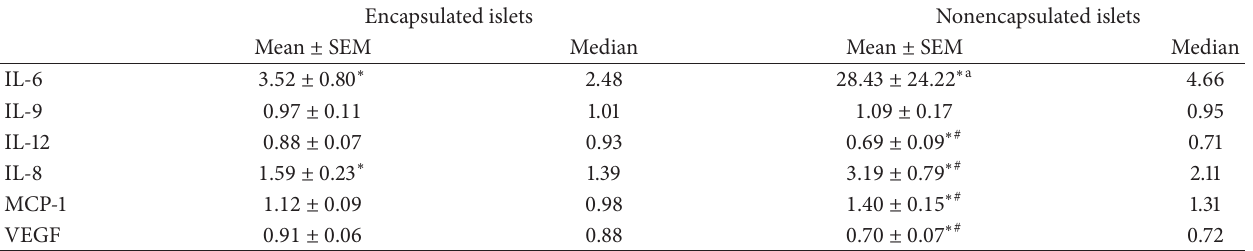
Table 3: Effect of hypoxia on islet secreted mediators by H/N ratios (fold increase by